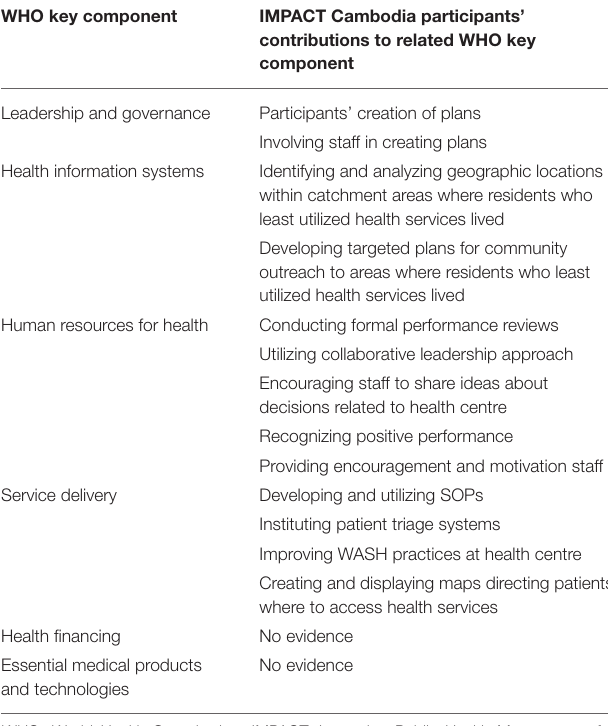
TABLE 6 | IMPACT Cambodia participants’ contributions to related WHO key components of a well-functioning health system. WHO key